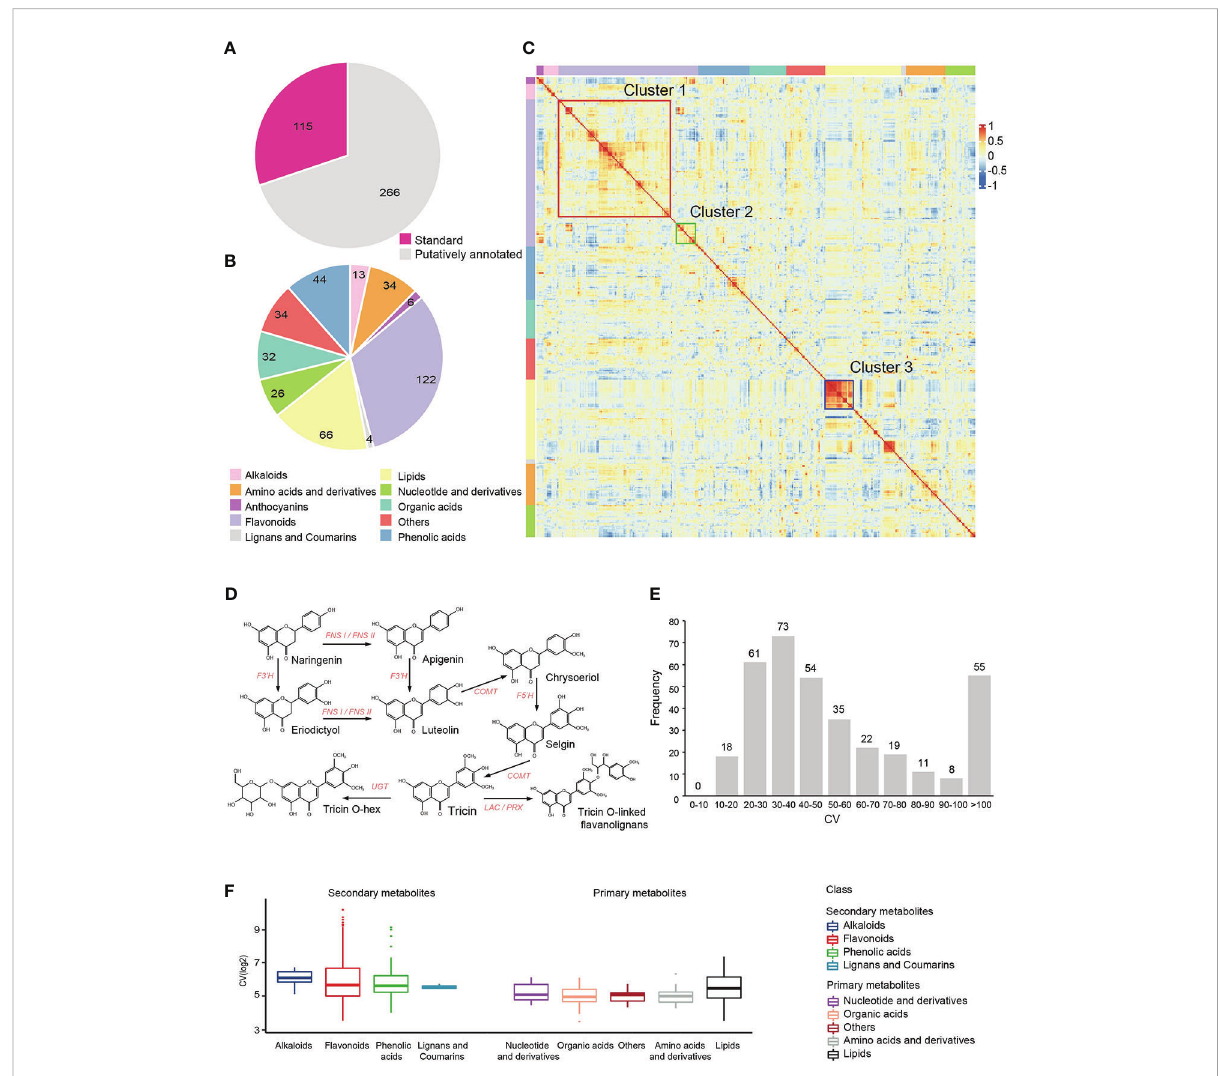
FIGURE 1 Metabolic pro fi ling in millet RIL population. (A, B) Number of detected metabolites and their classi fi cation. (C) Cluster heatmap of correlations among annotated metabolites. Pairwise Pearson ’ s correlations are shown in a heatmap, metabolites in same class are sorted according to correlation-based hierarchical cluster analysis. The level of correlation is indicated by red (positive correlation) and blue (negative correlation). (D) Metabolic pathways of fl avonoids in millet (Cluster 1). (E) Distribution of the coef fi cients of variation (CV) of annoted metabolic traits in the millet RIL population. (F) Statistical analysis of the coef fi cient of variation (CV) of each class of metabolites in the millet RIL